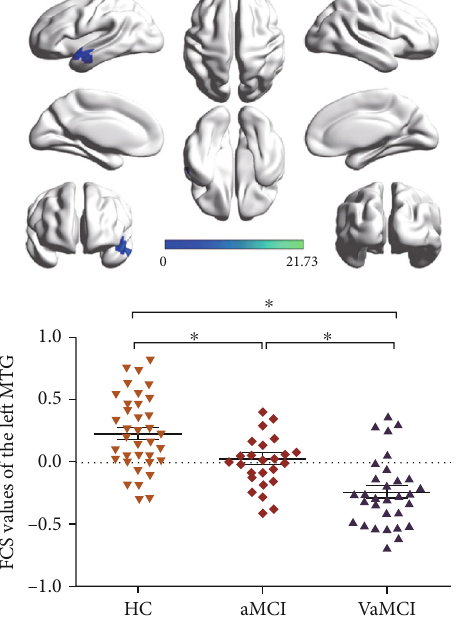
Figure 1: The result of one-way ANCOVA and post hoc analysis indicated signi fi cant decreased FCS in the left MTG among the VaMCI, aMCI, and HC. ∗ means p < 0 : 05 in the two-sample t -test using SPSS21. L: left; R: right; MTG: middle temporal gyrus; FCS: functional connectivity strength; VaMCI: vascular mild cognitive impairment; aMCI: amnestic mild cognitive impairment; HC: healthy control.